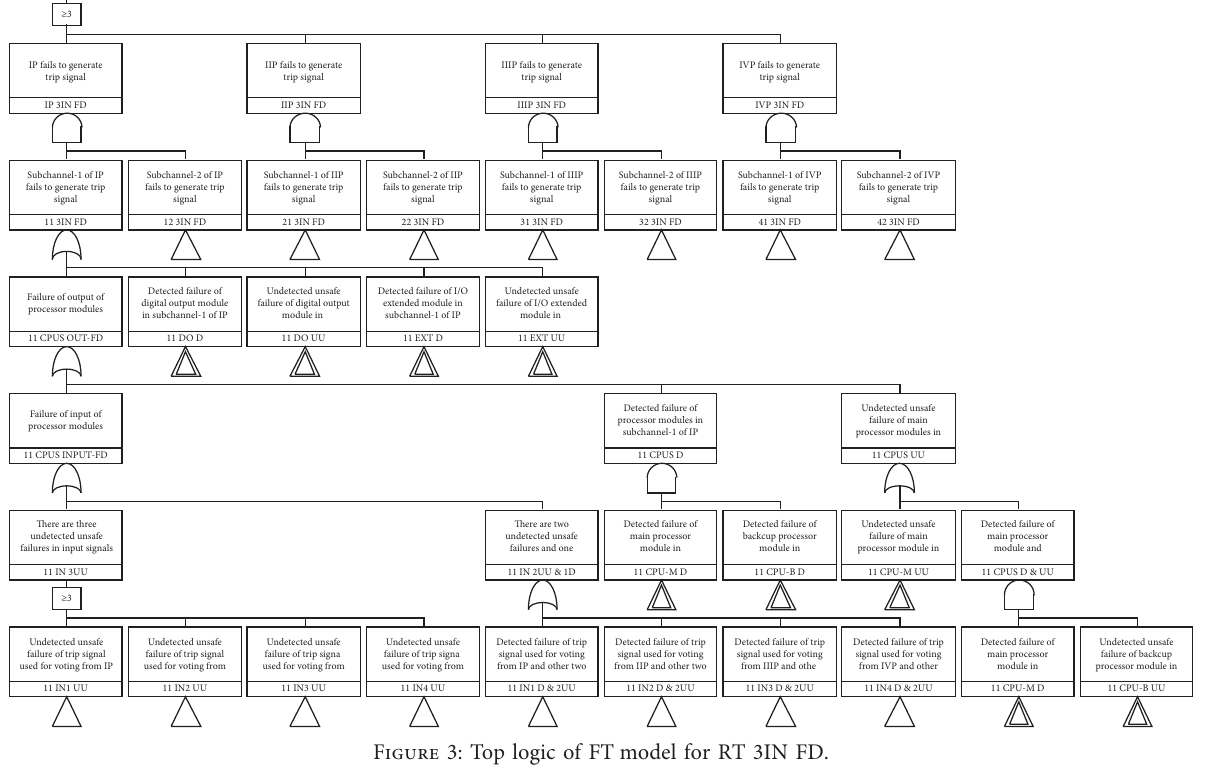
Figure 3: Top logic of FT model for RT 3IN FD.